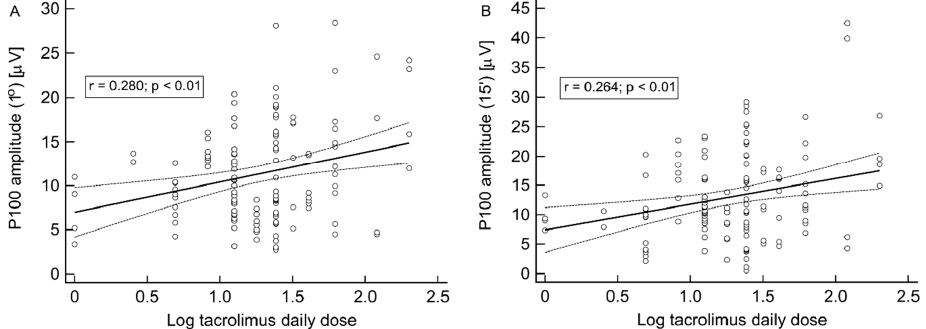
Figure 2. Results of the pattern VEP examination. The correlation between log tacrolimus daily dose and P100 wave (1 ◦ ) ( A ) or (15 (cid:48) ) ( B ) P100 amplitudes.